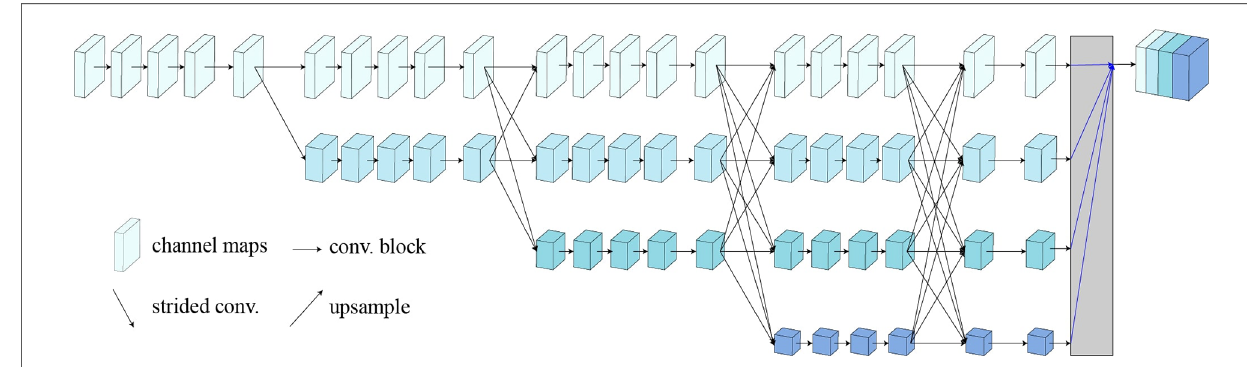
FIGURE 6 HRNetV2 architecture.